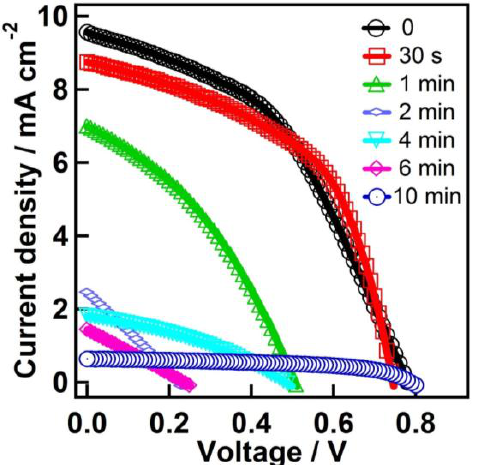
Figure 3. J – V characteristics of printable PSCs (device A) with different electrodeposition times of Mg(OH) 2 (device B). Table 1. Summary of the average solar cell parameters of devices A and B against the electrodeposition times of Mg(OH) 2 .